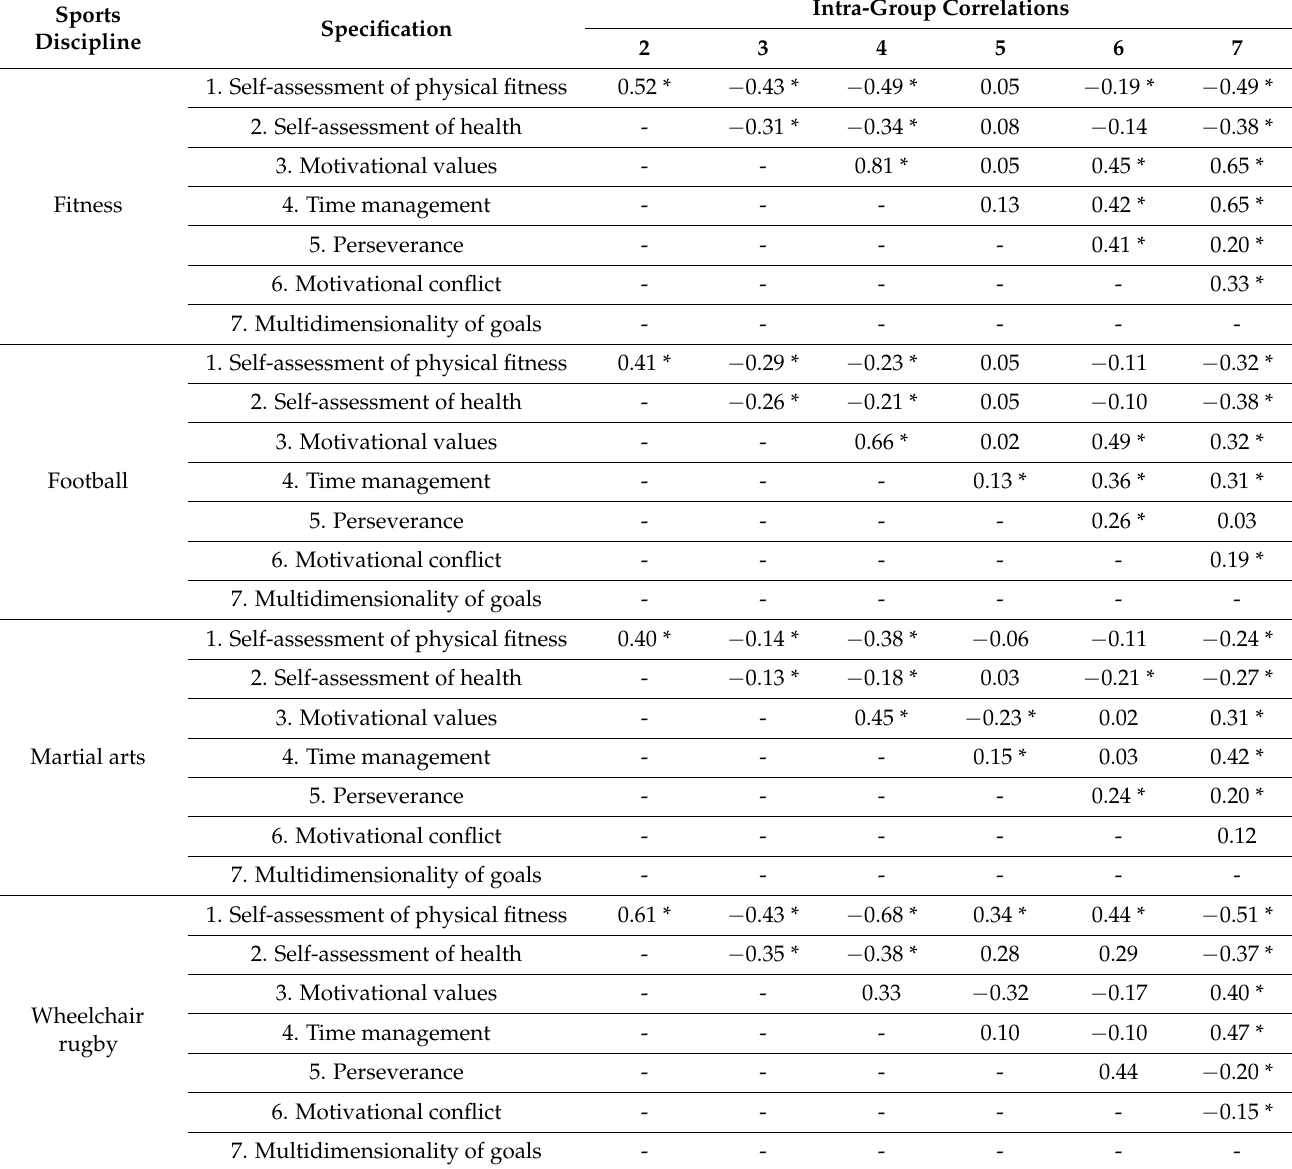
Table 6. Intra-group correlation coefficients (r) of self-assessment of physical fitness, health and motivational goals (IPAO) in people practicing fitness, football, martial arts and wheelchair